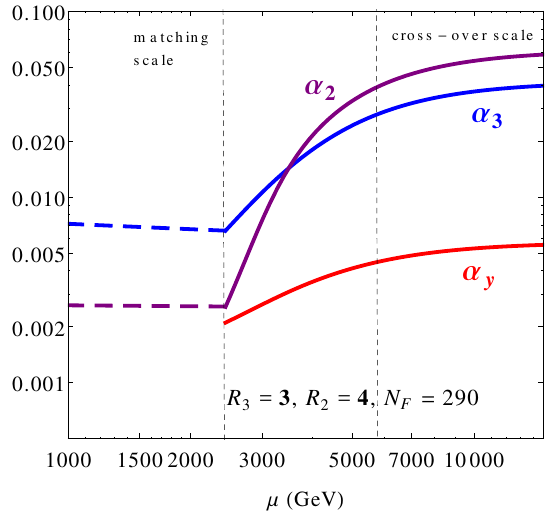
Figure 12 . Low scale matching from the fully interacting (cid:12)xed point FP 4 onto the SM for the benchmark scenario D with ( R 3 ; R 2 ; N F ) = ( 3 ; 4 ; 290) and matching scale M = 2 : 4 TeV. Once BSM matter (cid:12)elds are active, the weak coupling approaches asymptotic safety more rapidly than the strong